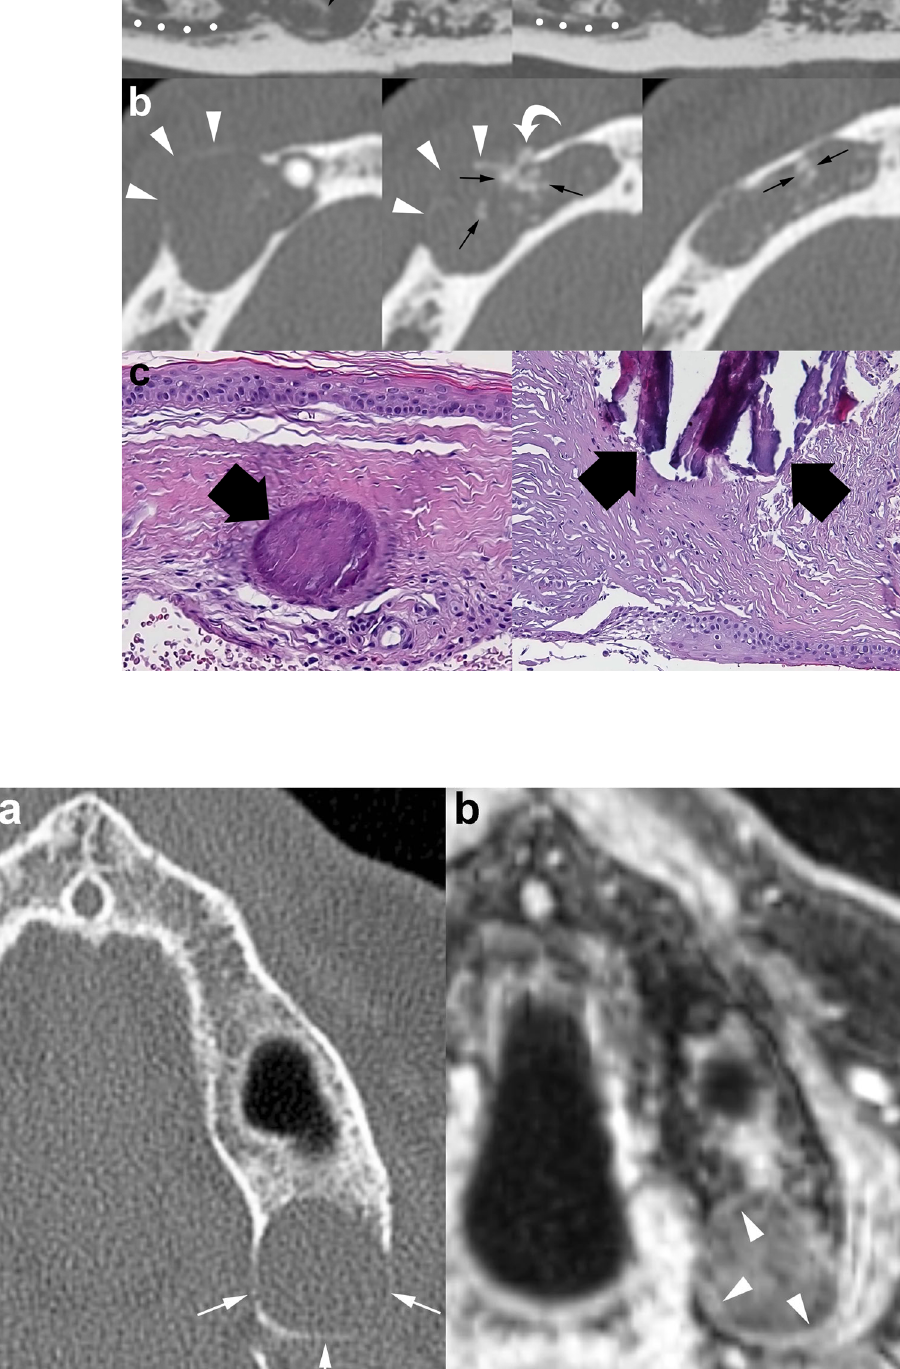
Fig. 13 Panoramic ( a ) and axial ( b ) MDCT images show an osteolytic lesion located in the interforaminal region of the mandible. The lesion, histologically proven to represent an OKC, causes expansion and thinning of the buccal cortex ( arrowheads ). MDCT images demonstrate numerous punctate high-density foci (calcification) within the lesion ( arrows ). One of these high-density foci shows extension into adjacent soft tissue ( curved arrow ). Dots , mesial portion of the mandibular canal. c Histological images show the characteristic epithelial lining and calcifications ( large black arrows ) within the underlying connective tissue (H-E 10×)